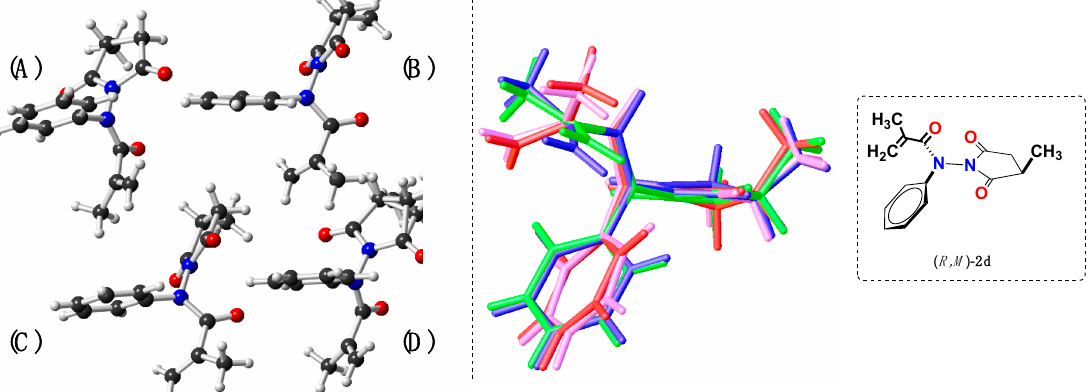
Figure 3. Single crystal XRD analysis performed for ( R )-methyl succinimide based hydrazide 2d . A– D represents (R,M)- 2d in a unit cell . The CCDC Deposition Number 1943951.